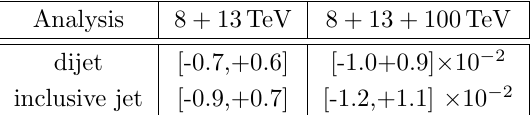
Table 5 . Projected 95% CL constraints on Z obtained by combining the individual 8, 13, and 100 TeV (cid:12)ts, including PDF correlations across di(cid:11)erent center of mass energies. In all cases, we use S no-jet and include only the most central rapidity